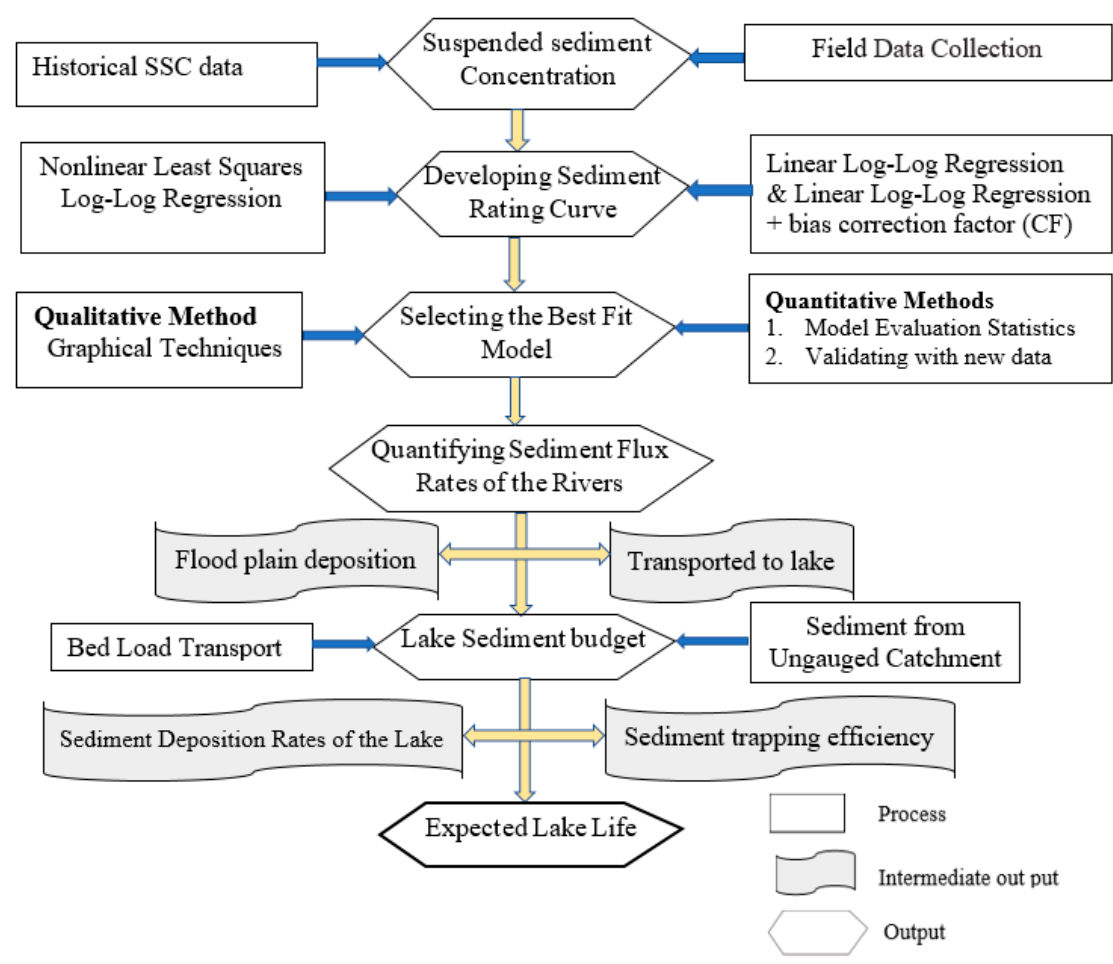
Figure 3. The workflow diagram used for the study. Suspended sediment concentration, (SSC).